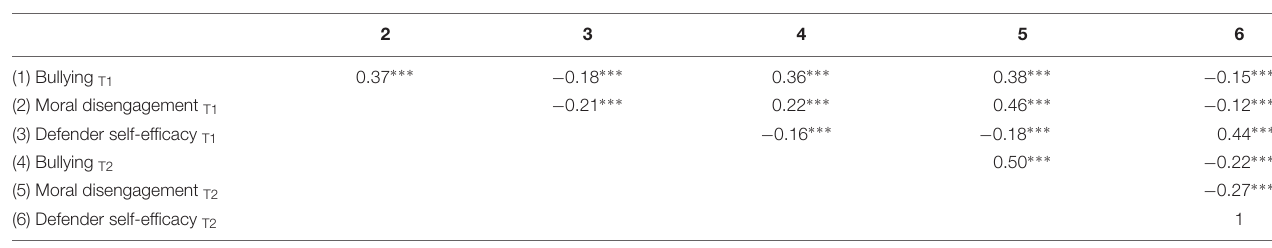
TABLE 2 | Correlations for individual level variables ( N = 1250).